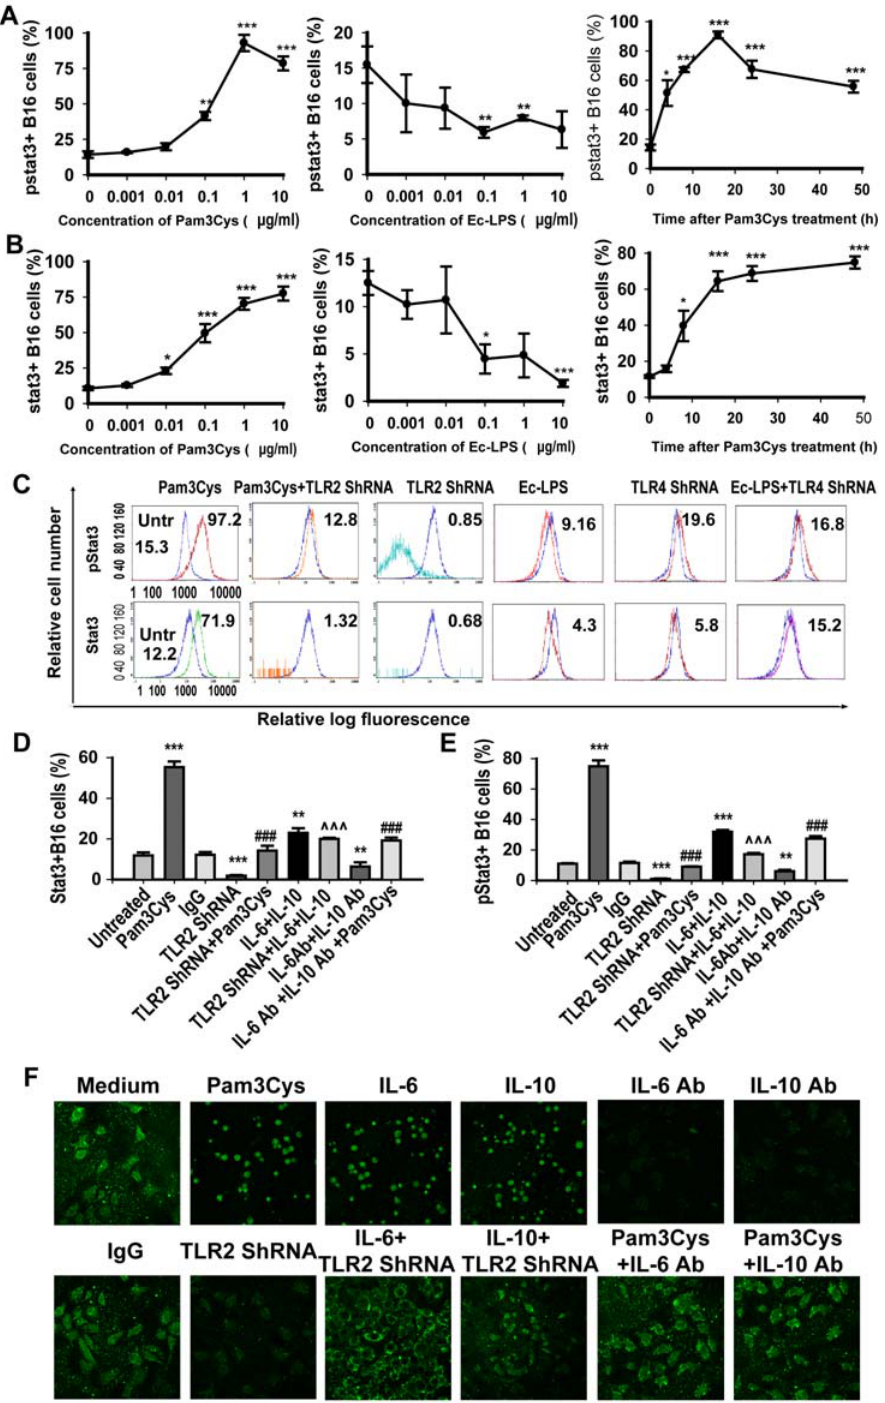
Figure 2. TLR2 KD inhibited the constitutive activity of Stat3 dependent of the IL-6/IL-10 signal pathway. The B16 cells were as indicated for 24 h. Cells were stained with pStat3 FITC or Stat3 TRITC Ab and the expression or phosphorylation of Stat3 was analyzed by intracellular flow cytometry. (A, B) Activation of TLR2 resulted in a concentration- and time-dependent phosphorylation (A) and expression (B) of Stat3 in B16 cells. (C) TLR2 KD, but not TLR4 KD, inhibited the expression and phosphorylation of Stat3 in B16 cells. (D, E) Activation of TLR2 enhanced the expression (D) and phosphorylation (E) of Stat3 in an IL-6 or IL-10-independent way. The cells in a medium containing 5% serum were treated as indicated in the methods section. The phosphorylation of Stat3 was analyzed by intracellular flow cytometry. Data are represented as mean 6 SE of four independent experiments. F , TLR2 activation resulted in a nucleus translocation of Stat3 dependent of IL-6 or IL-10. B16 cells were treated as indicated, and the nucleus translocation of Stat3 in B16 cells was determined by a confocal laser 3000 Analyzer. Representative micrographs from three translocation assays were shown (Original magnification, 20 6 ). * P , 0.05, ** P , 0.01, *** P , 0.001 versus untreated group; # P , 0.05, ## P , 0.01, ### P , 0.001 versus Pam3Cys treated group; ˆ P , 0.05, ˆˆ P , 0.01, ˆˆˆ P , 0.001 versus TLR2 ShRNA treated group.